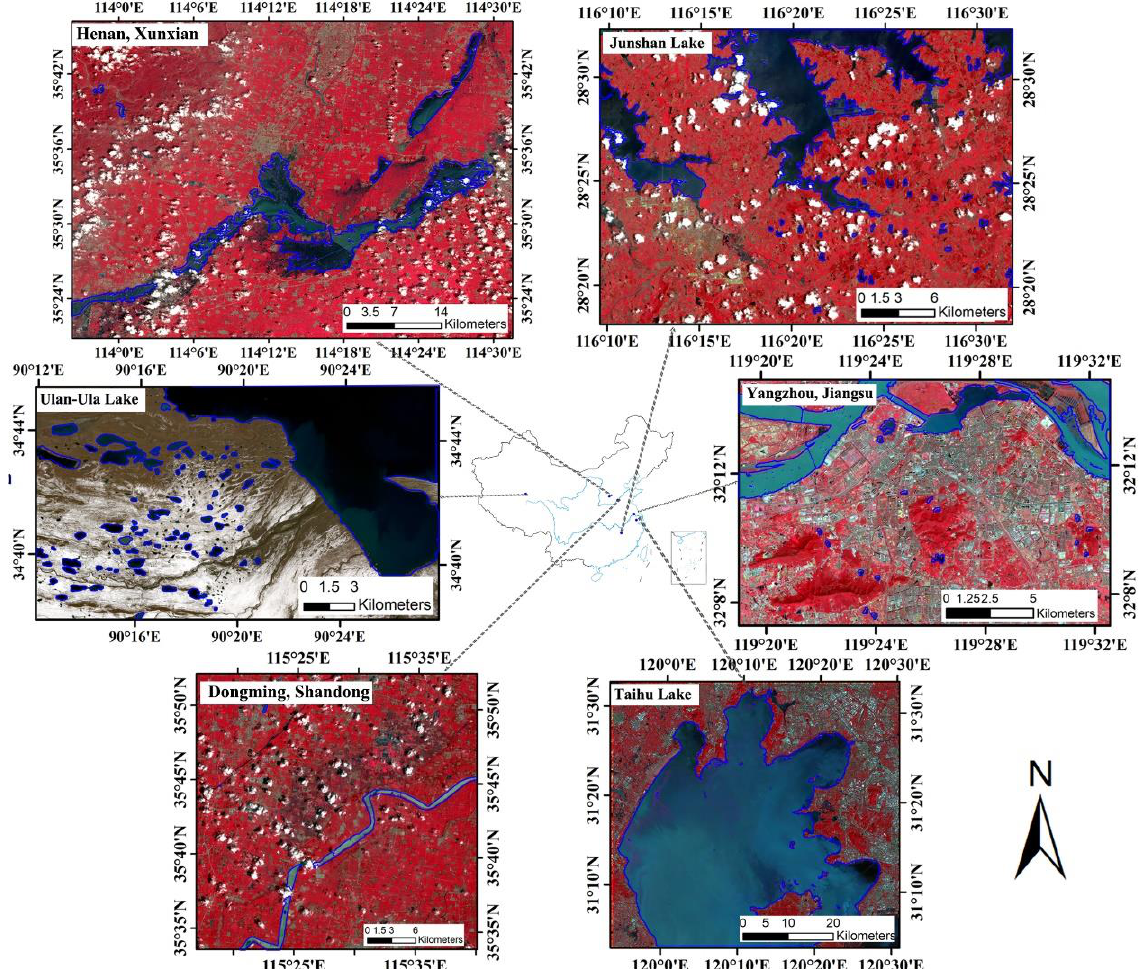
Figure 1. Spatial distribution of the research areas over China used for testing the SAR and Optical Imagery Water Index (SOWI) in this study.